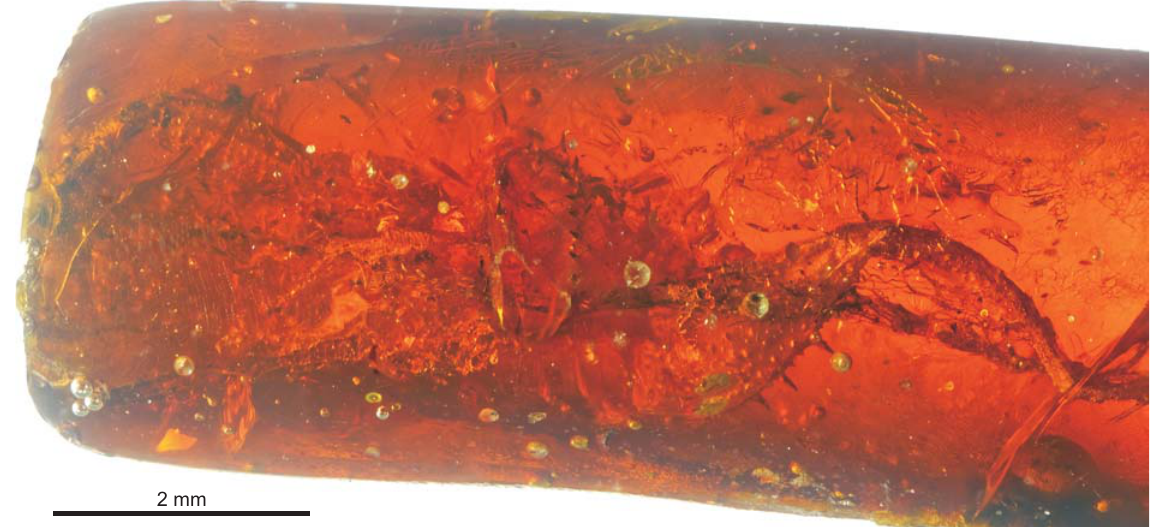
Fig. 7. Mantoidid mantis ? Pseudomantoida extendidera gen. et sp. nov., MNHN-F.A71140 Le Quesnoy, France,